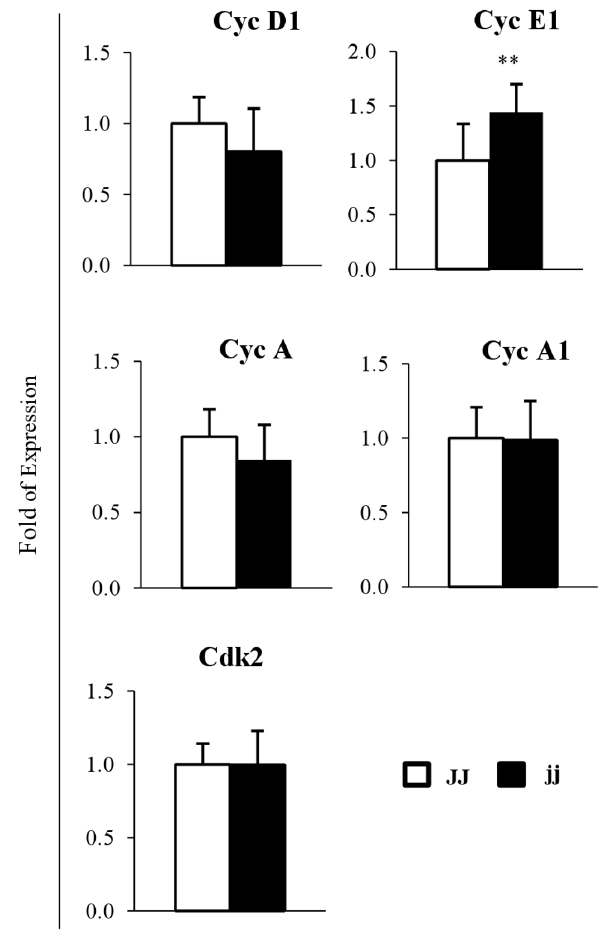
Figure 2. mRNA relative expression of Cyclin D1, Cyclin E1, Cyclin A, A1 and Cdk2. □ Normal homozygous JJ and ■ Hyperbilirubinemic homozygous jj Gunn rat. Data are expressed as mean ± SD. Statistical significance: ** p <